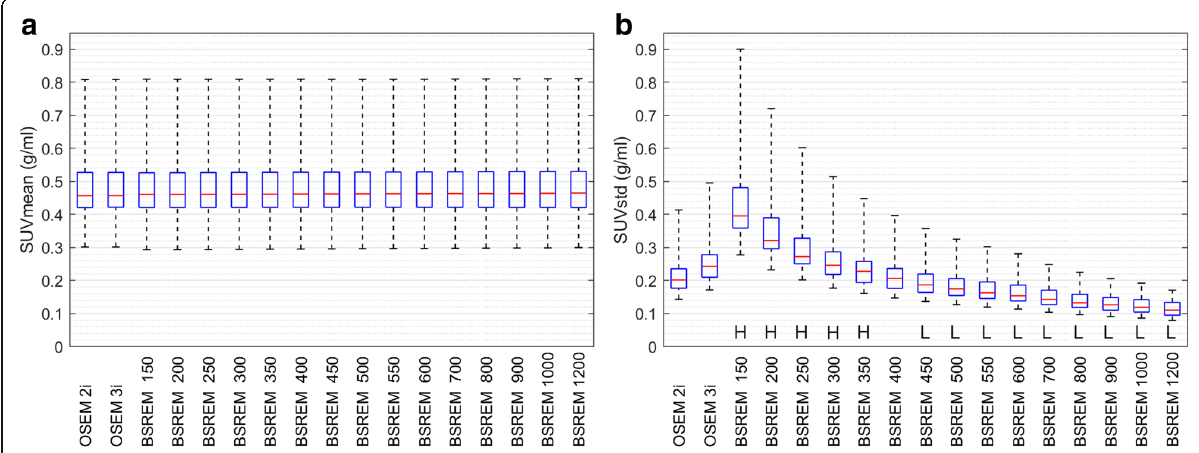
Fig. 3 Box and whisker plots showing SUVmean and SUVstd distributions from background ROIs in 25 patients. The left panel shows SUVmean ( a ) and the right panel shows SUVstd ( b ). Each panel shows from left to right the results of the TOF OSEM reconstructions with 28 subsets and 2 and 3 iterations, followed by TOF BSREM reconstructions with regularization parameter β = 150, 200, 250, 300, 350, 400, 450, 500, 550, 600, 700, 800, 900, 1000, and 1200. H indicates significantly higher values, and L indicates significantly lower parameter values for TOF BSREM compared